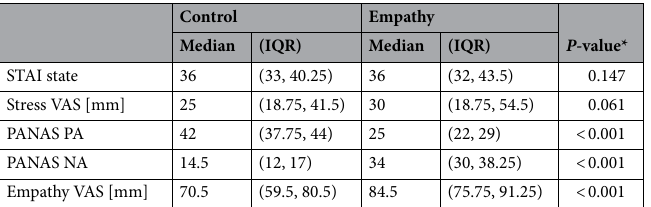
Table 2. Self-reported stress pre, and empathy post empathy trigger or control film sequence. *Wilcoxon signed-rank test.